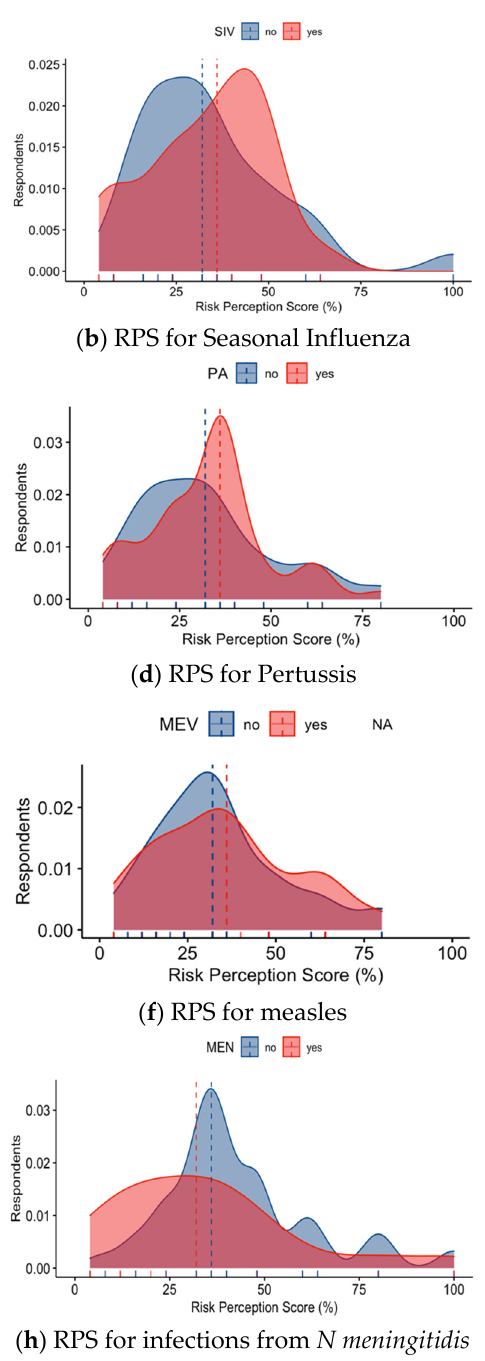
Figure A1. Risk perception score for: ( a ) seasonal influenza vaccine (SIV), ( c ) pertussis vaccine (PA), ( e ) measles vaccine (MeV), ( g ) meningitis from N meningitidis (MEN), and corresponding natural infections: seasonal influenza ( b ), pertussis ( d ), measles ( f ), infections from N meningitidis ( h ), all of them broken down by having or having not been vaccinated (SIV: 2018; PA, MeV, MEN = lifetime).